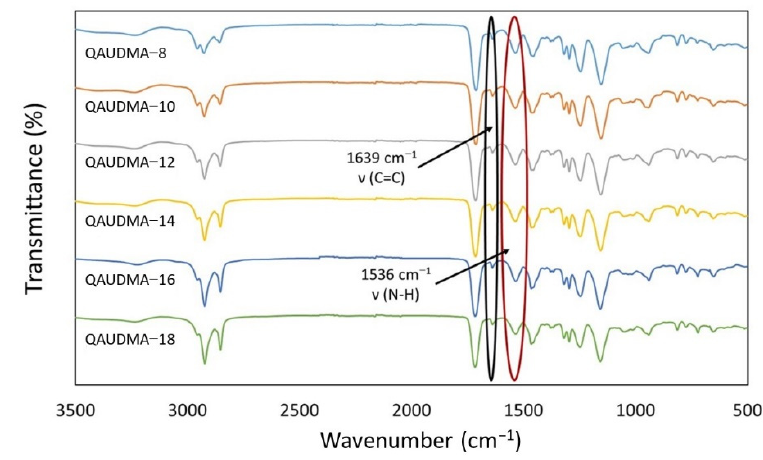
Figure 7. FTIR spectra of QAUDMAs. In Table 1, the structural and physicochemical properties of QAUDMA monomers are summarized. The MW of QAUDMAs ranged from 970 to 1250 g/mol and increased with the increasing length of the N -alkyl substituent. The concentration of double bonds